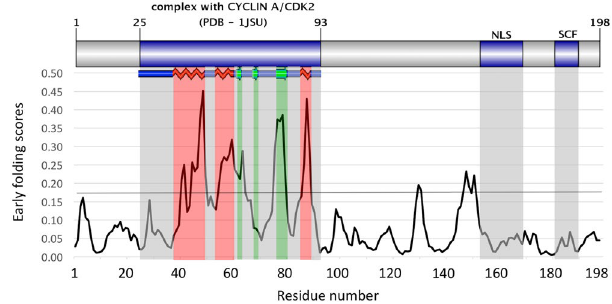
Figure 4. The domain map of p27 Kip1 with the EFoldMine prediction. The blue shaded areas indicate known interaction sites, the red and green shaded areas within the cyclin A/CDK2 interacting region indicate helix and sheet forming segments,